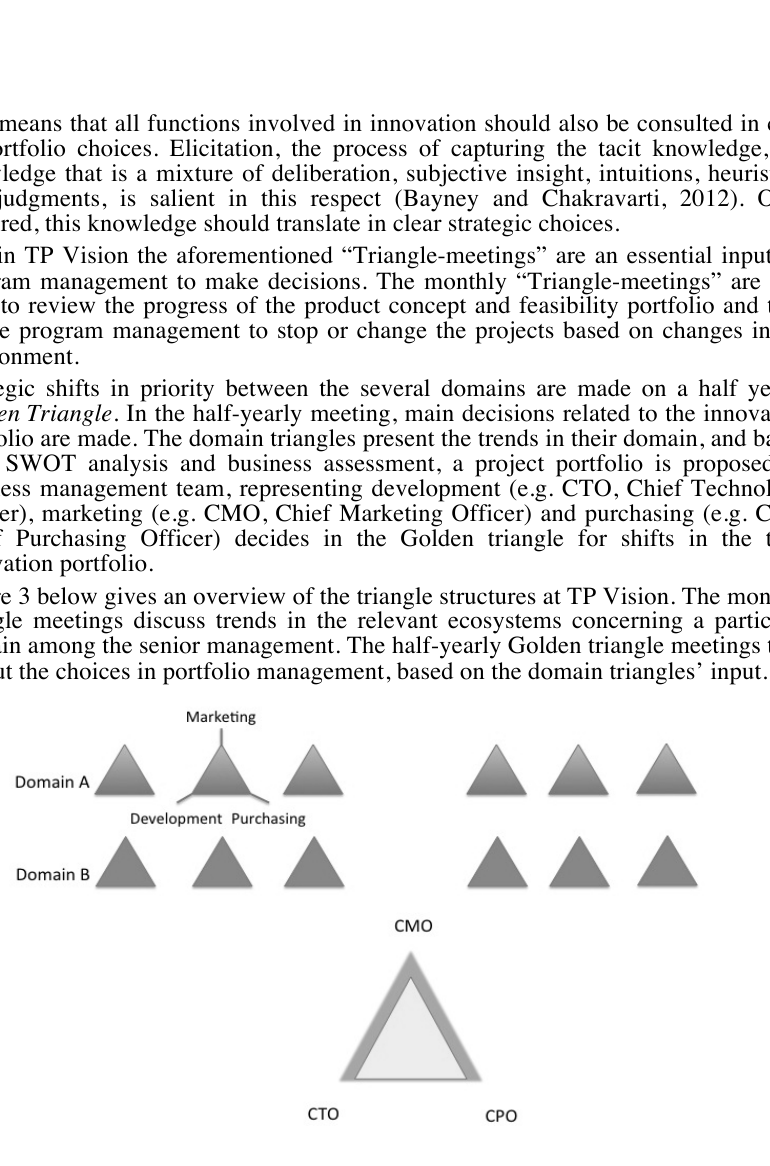
Fig. 3 The triangle structure of TP Vision, with the monthly domain triangles on top and the half-yearly golden triangle